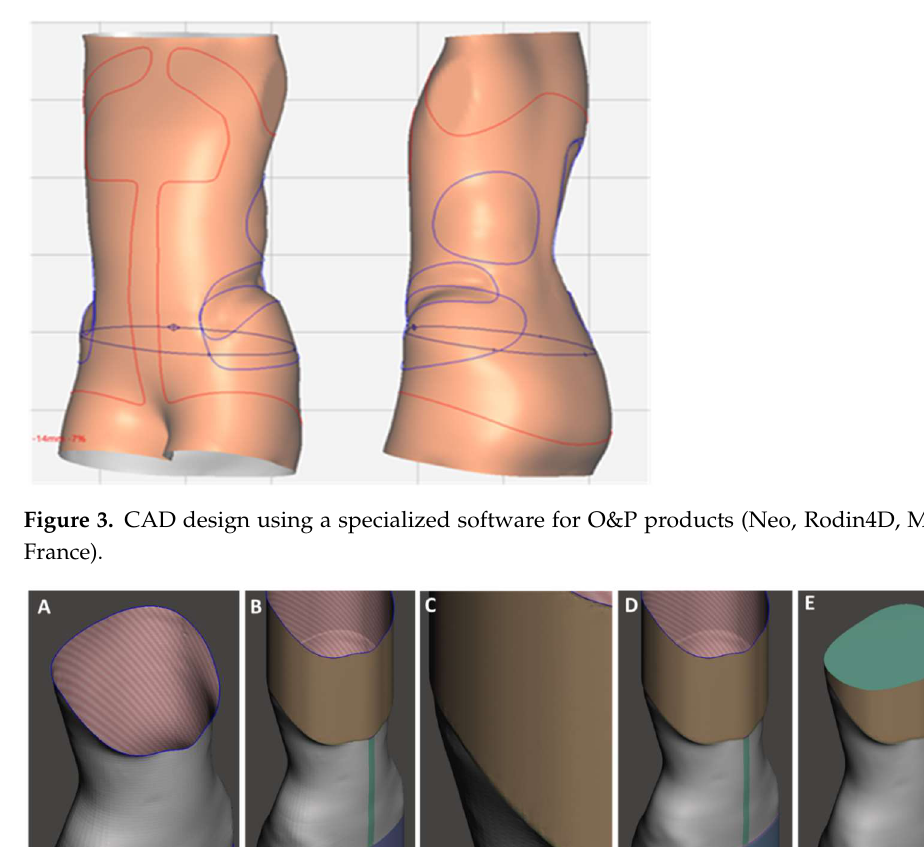
Figure 4. Final steps of the CAD modelling phase: ( A ) CAD model after modelling phase with spe- cialized O&P software; ( B ) vertical extrusion of the borders; ( C ) detail of the offset on the extruded part; ( D ) re-mesh and smoothing; ( E ) plane cut and surface